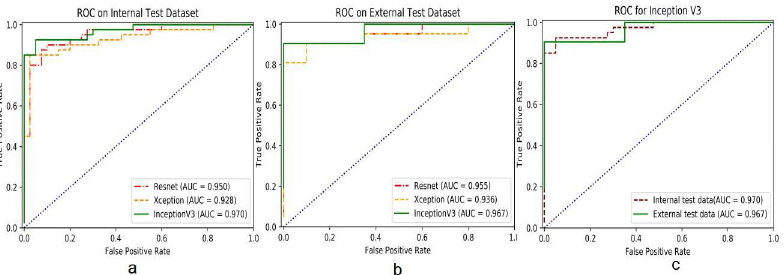
Fig 3. The AUC/ROCs for detection of PH from normal. Comparision of AUC/ROCs in internal test. The InceptionV3 model had an AUC (0.970) greater than the other two models (a). Comparision of AUC/ROCs in external test. The InceptionV3 model provided the best AUC (0.967) compared to the other ones (b). The AUC performed by InceptionV3 model in external test was slightly lower than that in internal test (0.967 VS 0.970 respetively) (c). ROC, receiver operating characteristic; AUC, area under the ROC curve; PH, pulmonary